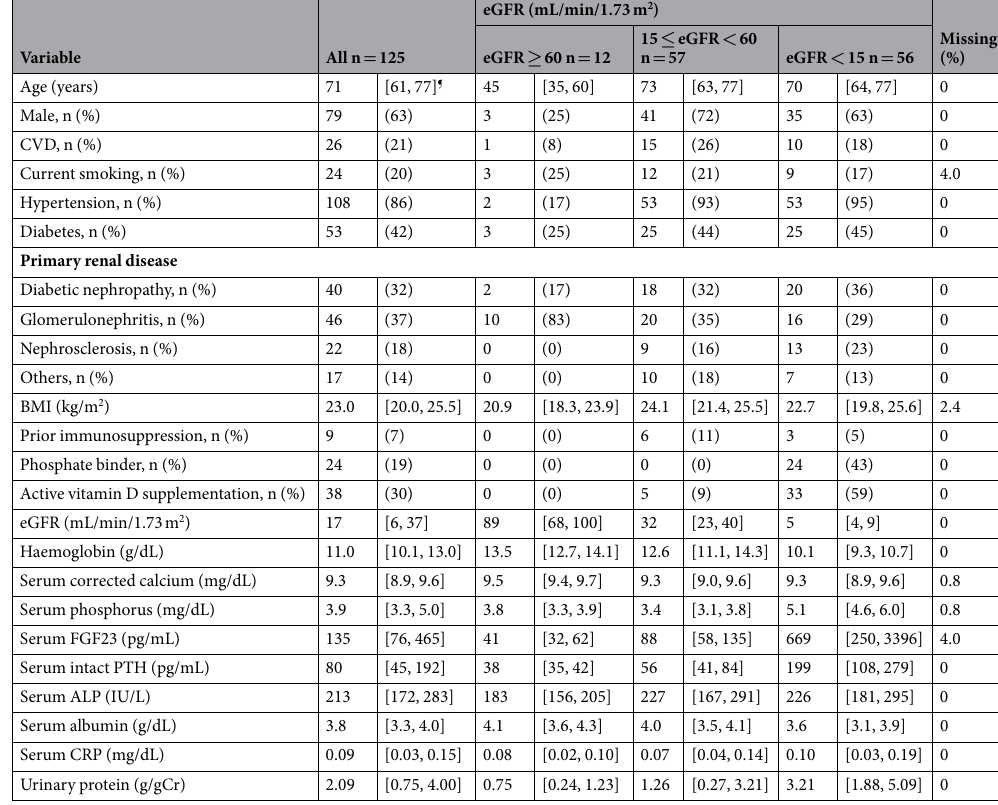
Table 1. Characteristics of the study population. Data are presented as numbers (%) or ¶ median [interquartile range]. CVD, cardiovascular disease; BMI, body mass index; eGFR, estimated glomerular filtration rate; FGF23, fibroblast growth factor 23; PTH, parathyroid hormone; ALP, alkaline phosphatase; CRP, C reactive